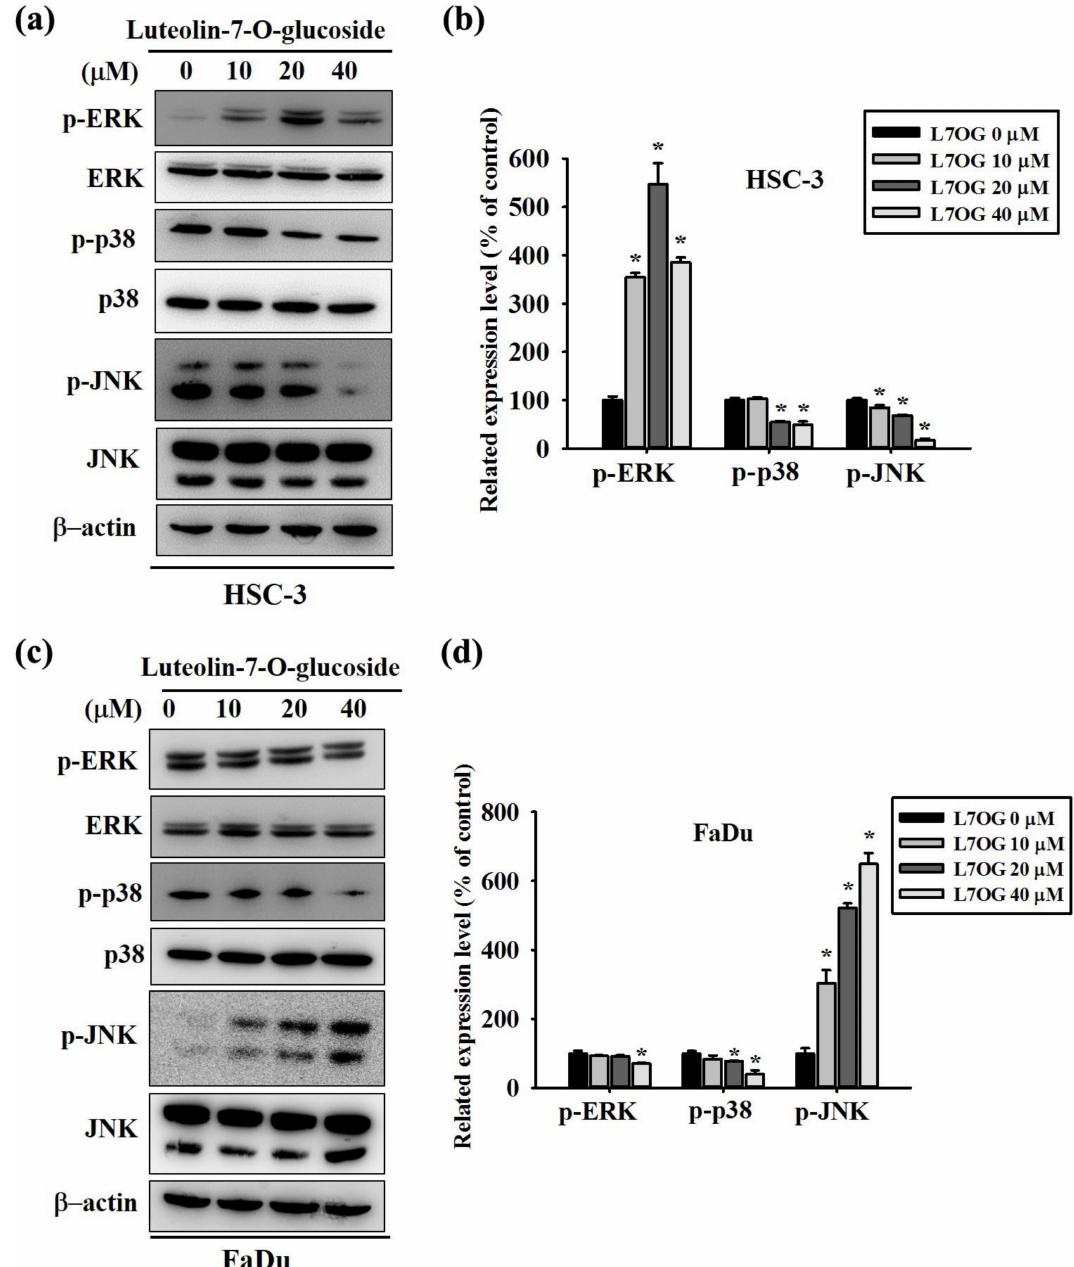
Figure 5. Luteolin-7-O-glucoside inhibits p38 pathway in human oral cancer cells. The phosphorylation as well as the total protein expressions of extracellular signal-regulated kinase 1 / 2 (ERK1 / 2), Jun N-terminal kinase 1 / 2 (JNK1 / 2), and p38 were measured after luteolin-7-O-glucoside treatment for 24 h in ( a , b ) HSC-3 and ( c , d ) FaDu cell lines. The values are represented as mean ± SD of at least three independent experiments. * p < 0.05, compared with the control